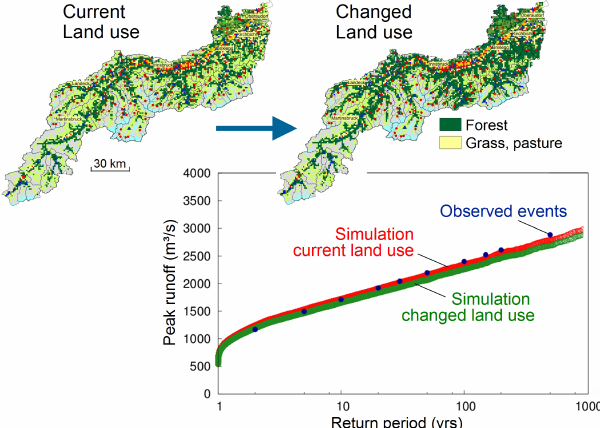
Figure 6. Effects of afforestation on floods for the 9700km 2 Inn catchment at Oberaudorf in Austria using a distributed rainfall– runoff model. Considering that the catchment area is large, the rel- evant runoff generation mechanism is saturation excess and thus the effect of land-use change (an additional 100000ha of forest) is small. The flood peak runoff associated with a return period of 100 years is reduced by only 4% (Blöschl et al.,